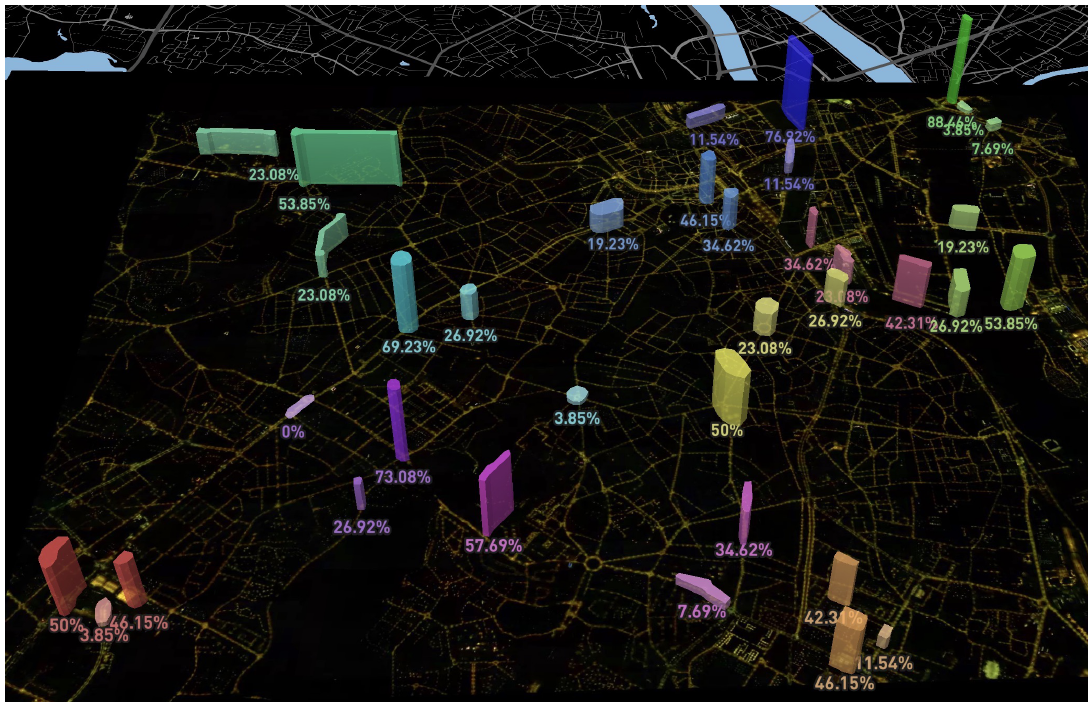
Figure 12. An overview over the 12 scenarios (color-coded) and the distribution of choices participants made between the three candidates in